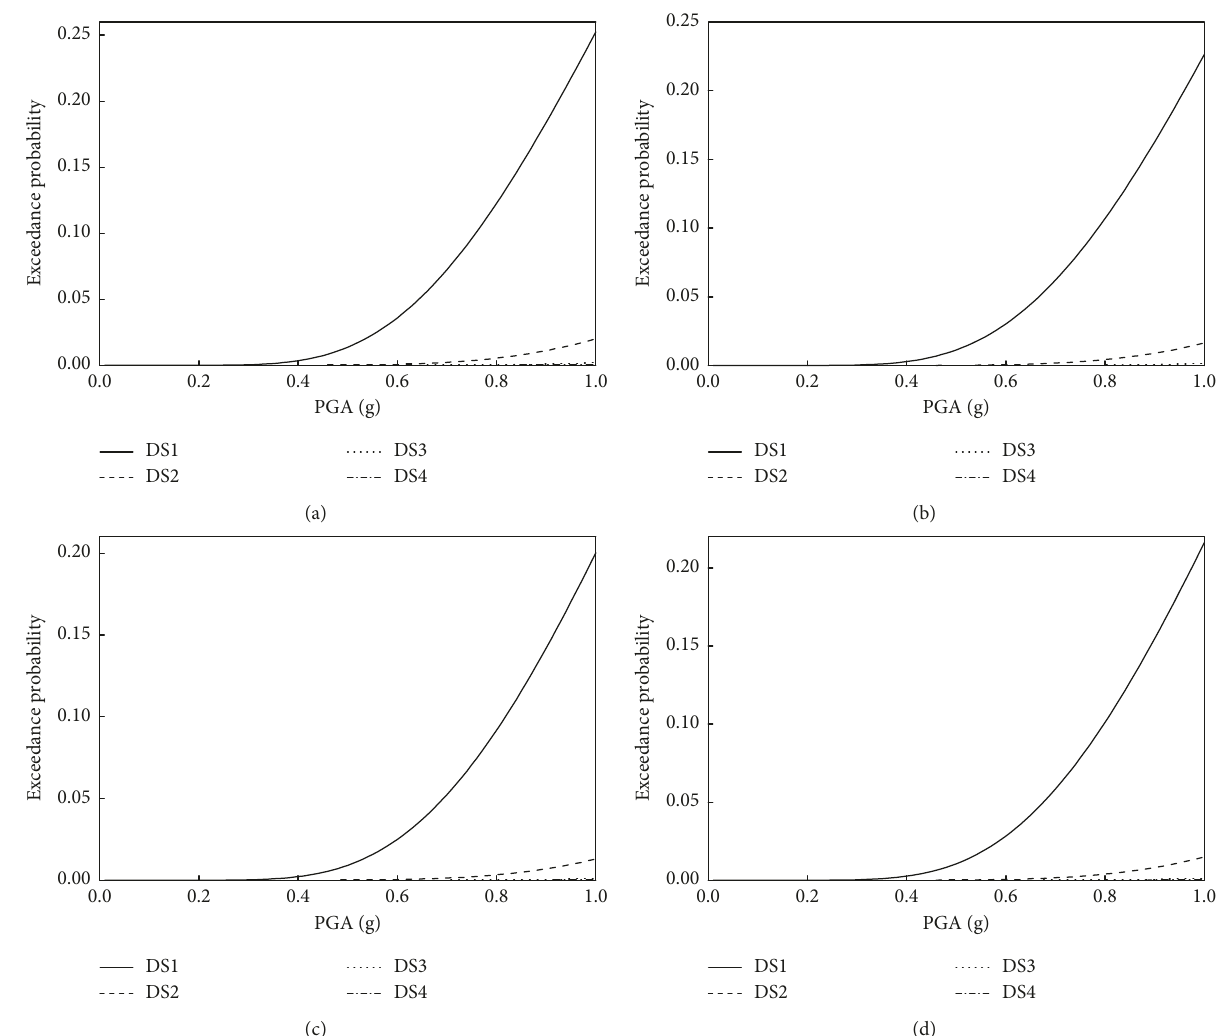
Figure 14: Structural peak acceleration when μ the structural peak acceleration in Table 2). (a) V d and C 0 kN s/m. (d) V d (cid:31) ·